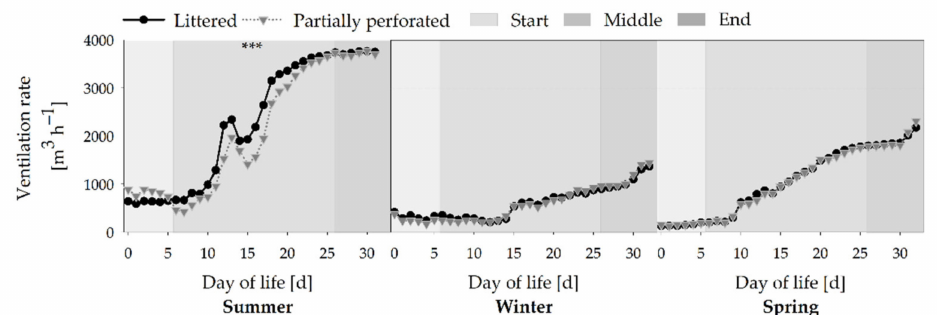
Figure 7. Average daily ventilation rate from broiler houses with two different floor types measured over three different fattening periods ( n = 1.440 values per day and barn). Significant differences between both floor types within the three different sections (start, middle, end of the fattening period) are marked by asterisks: *** p < 0.001.